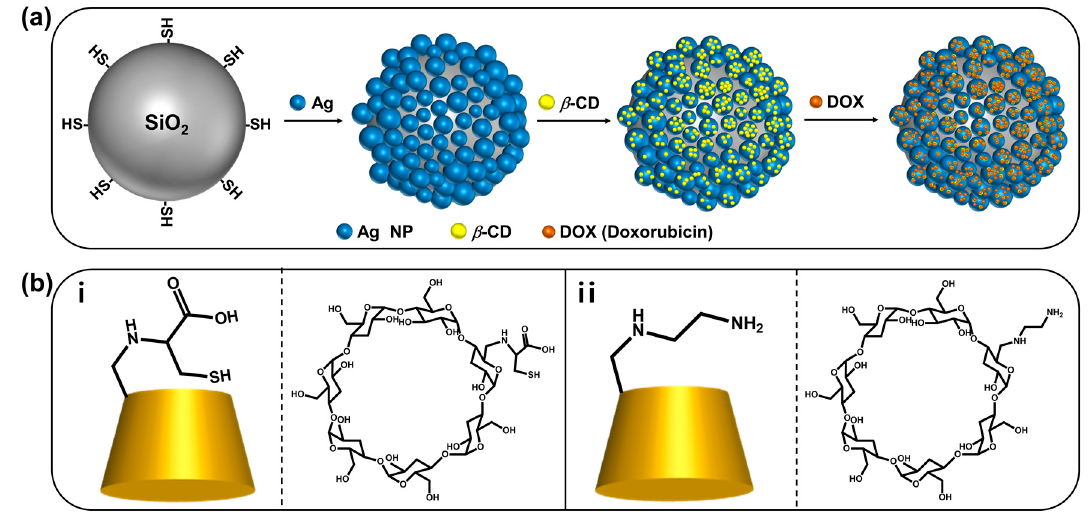
Figure 1. ( a ) Procedure for synthesizing SiO 2 @Ag NPs and introducing β -CD derivatives and DOX. ( b ) Chemical structures and illustration of (i) cysteinyl- β -CD and (ii) EDA- β ‐ CD.